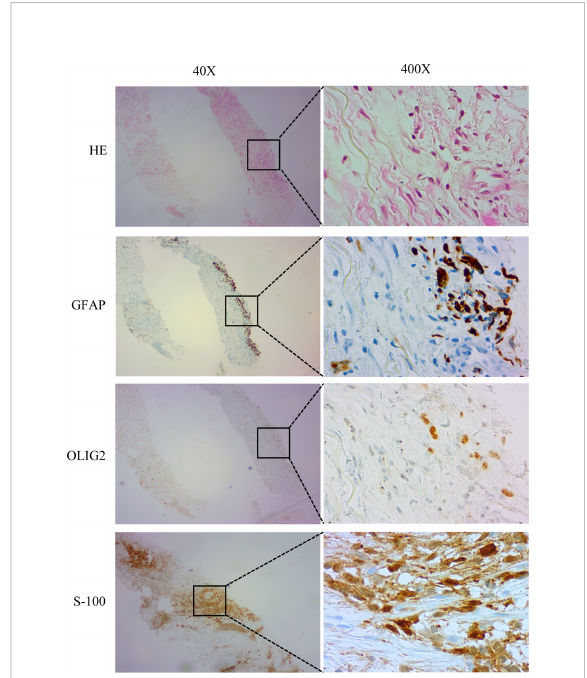
FIGURE 3 Histopathology and immunostaining of metastatic lung lesions. Hematoxylin-Eosin (HE) staining showed that the lung lesion was neoplastic. Immunohistochemistry (IHC) showed positive GFAP, OLIG2 and S-100. Magni fi cation: 40X and